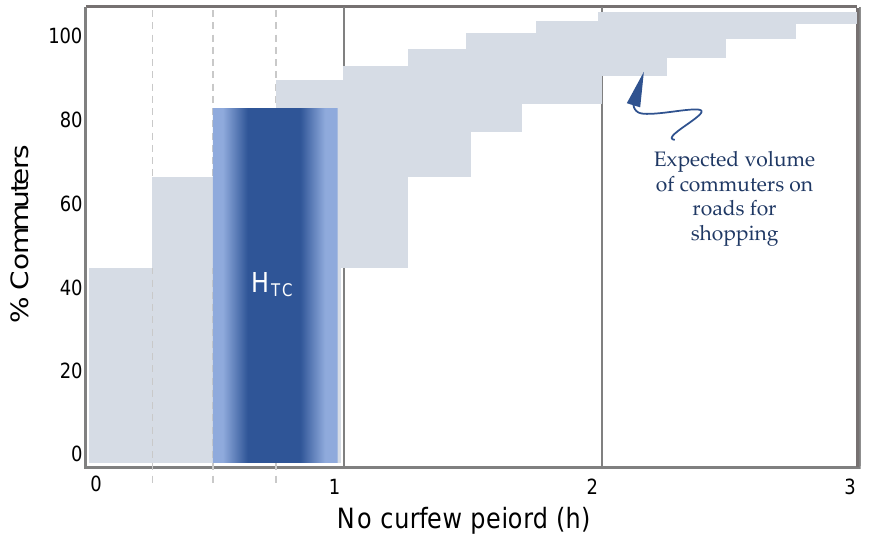
Figure 4. A theoretical illustration of highest traffic congestion period after COVID-19 curfew timings. Assumed no curfew period is 3 h based on 2021 no curfew timings in Saudi Arabia.